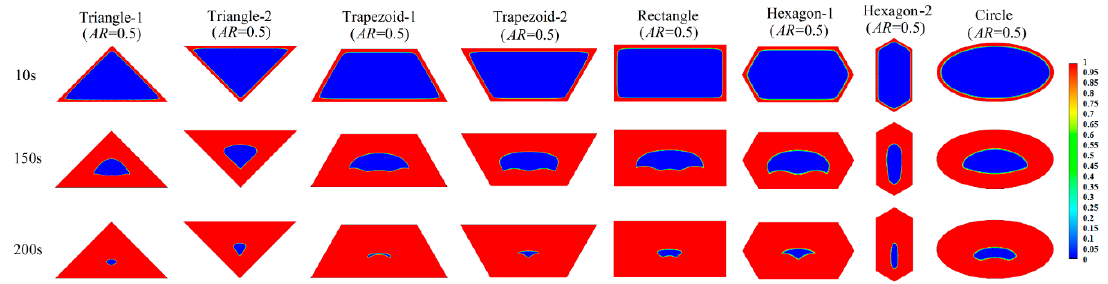
Figure 9. Liquid fractions of the triangular, trapezoidal, rectangular, hexagonal, and circular cells with smaller aspect ratios ( AR = 0.5) at Ra = 3.095 × 10 5 ( A = 100 mm 2 ).